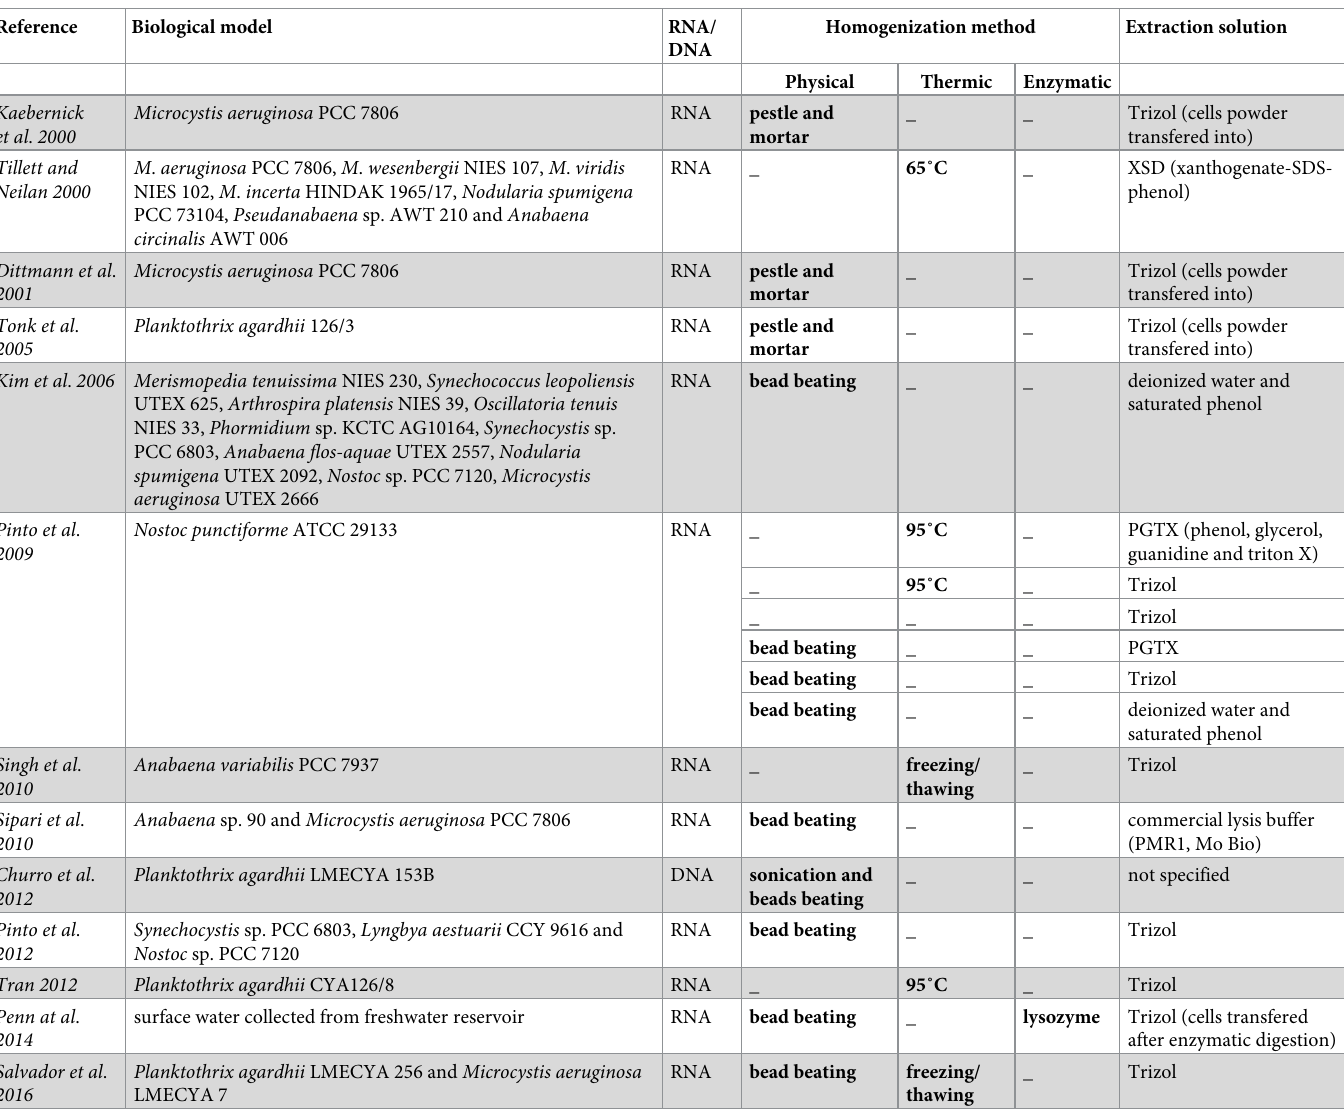
Table 1. Main existing extraction protocols for cyanobacteria nucleic acid. Biological model, homogenization method, and extraction solution used in these studies are